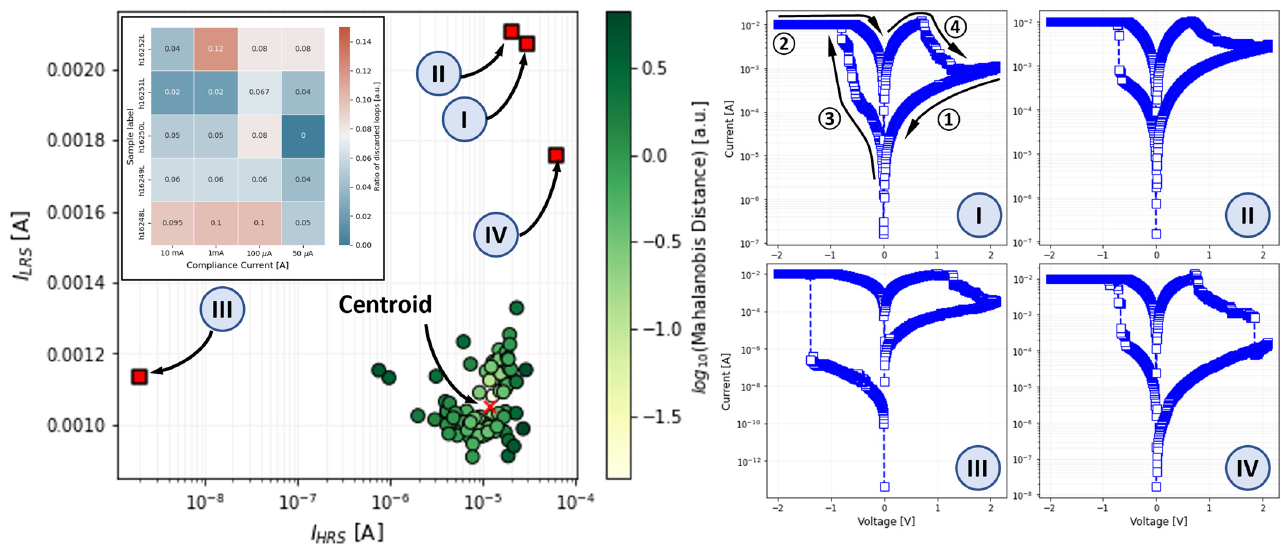
Figure 5. Example of the outlier detection using the Mahalanobis distance. Note that in this example we have considered only 2 variables for the sake of a graphical representation and 4 anomalous cases were found (indicated in red) for which the resulting p ‐ value was above 0.1.